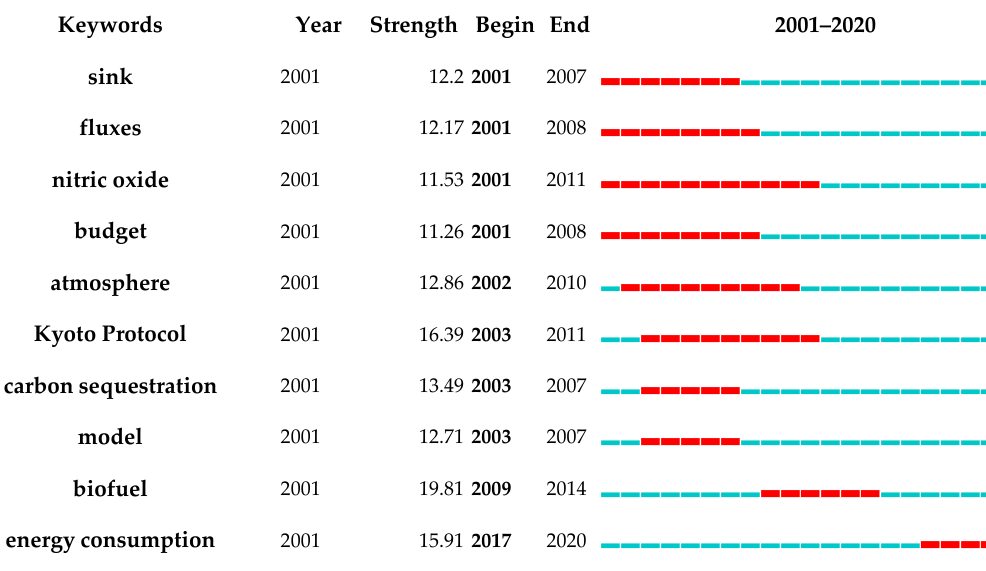
Figure 11 . Burst intensity map of keywords for carbon emissions research in the WoS database . Figure 11. Burst intensity map of keywords for carbon emissions research in the WoS